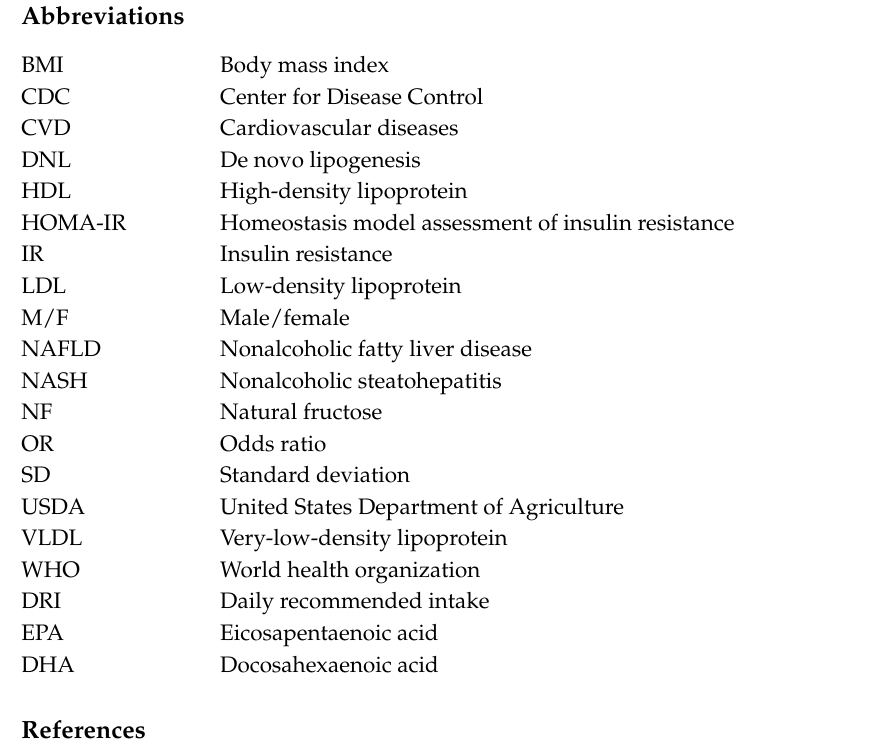
Figure S1: Results of the Bland Altman analyses (% of energy from protein), Figure S2: Results of the Bland Altman analyses (% of energy from fat), Figure S3: Results of the Bland Altman analyses (% of energy from carbohydrates), Table S1, Food